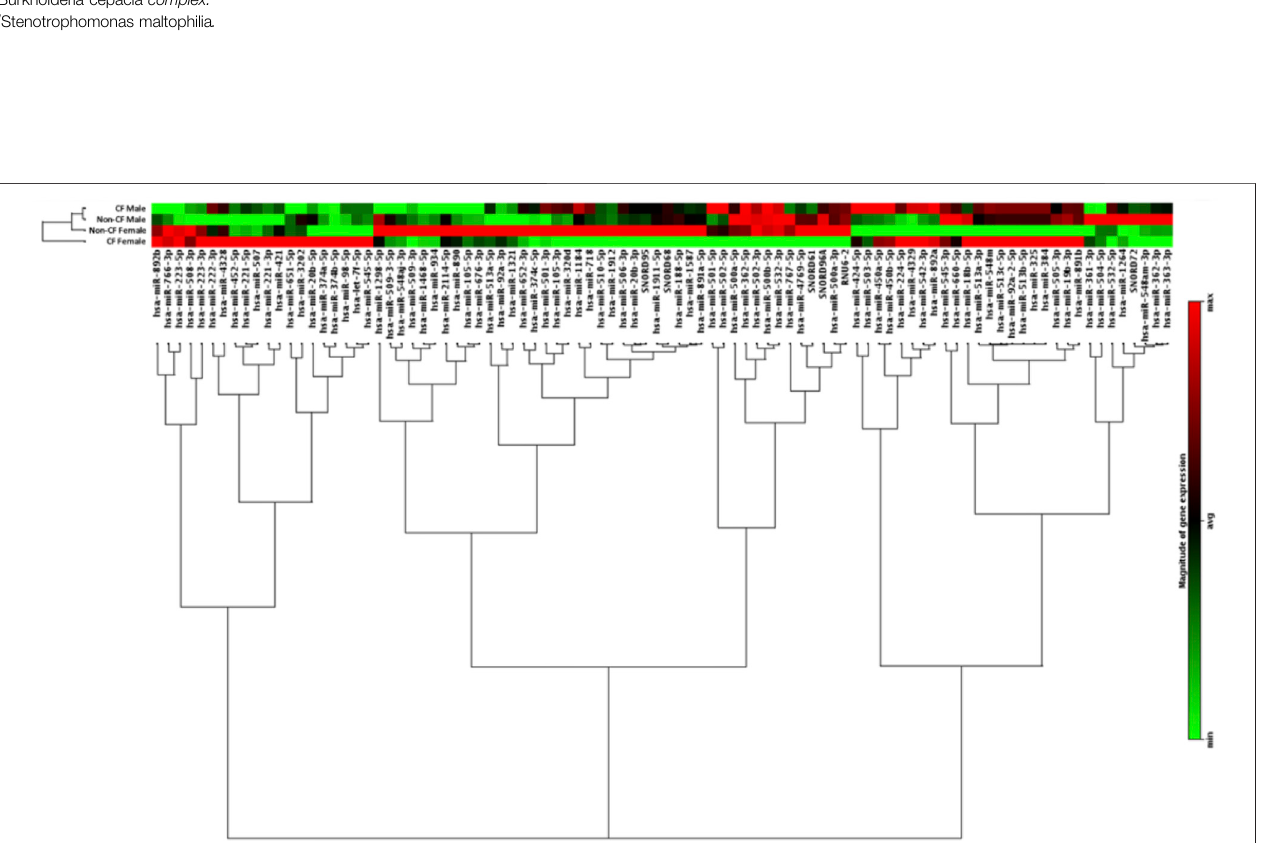
FIGURE 1 | Expression of X-chromosome located miRNA in CD14 + monocytes from people with and without CF, annotated by gender and CF pathology. Hierarchical clustering dendrogram showing expression patterns of X-chromosome located microRNAs in males and females with and without CF ( n (cid:1) 6 each). CD14 + monocytes were obtained from theperipheral blood of each individual. RNAwas isolated from each sample and theexpression ofX-chromosome located miRNAswas examined by qRT-PCR array. Colour density is proportional to magnitude of